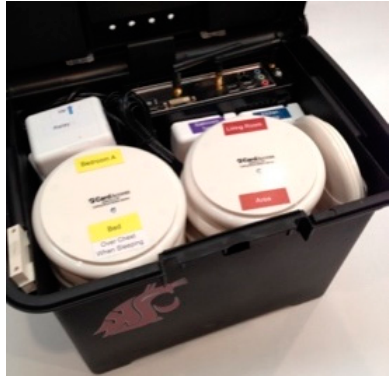
Figure 3. The Center for Advanced Studies in Adaptive Systems (CASAS) Smart Home in a Box